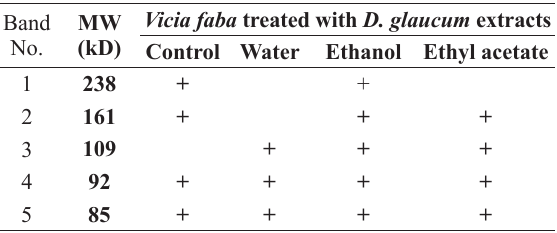
sDs-PAGE analysis of V. faba protein bands extracted from the leaf and treated with different D. glaucum